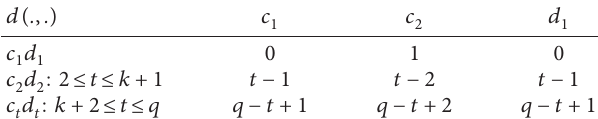
Table 8: Codes of spokes of GP ( q, 1 ) .